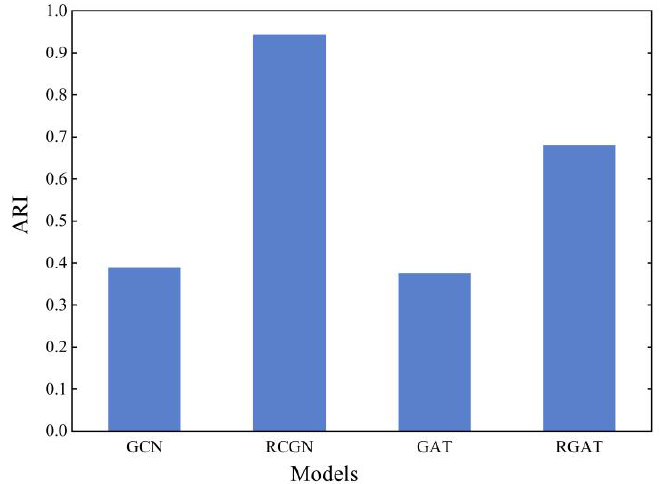
Figure 4. ARI values of the results predicted by the four models.